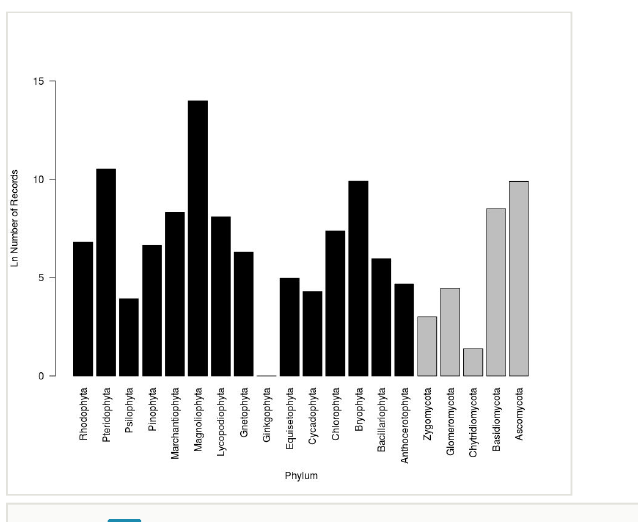
Figure 6. Number of occurrence records distributed among Plantae (black bars) and Fungi (gray bars) kingdoms by phyla published outside national borders (Logarithmic scale).